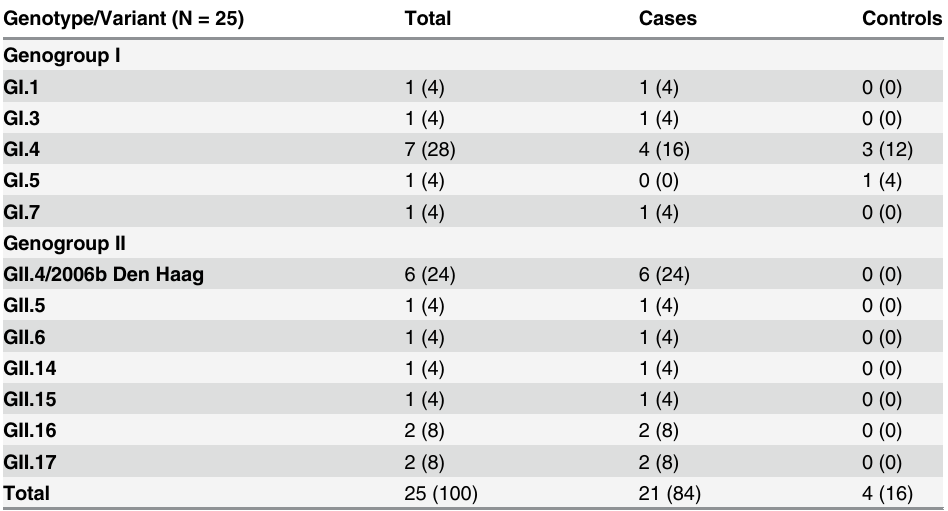
Table 3. Norovirus genotypes/varients detected in diarrhea caes versus controls, no., (%) a